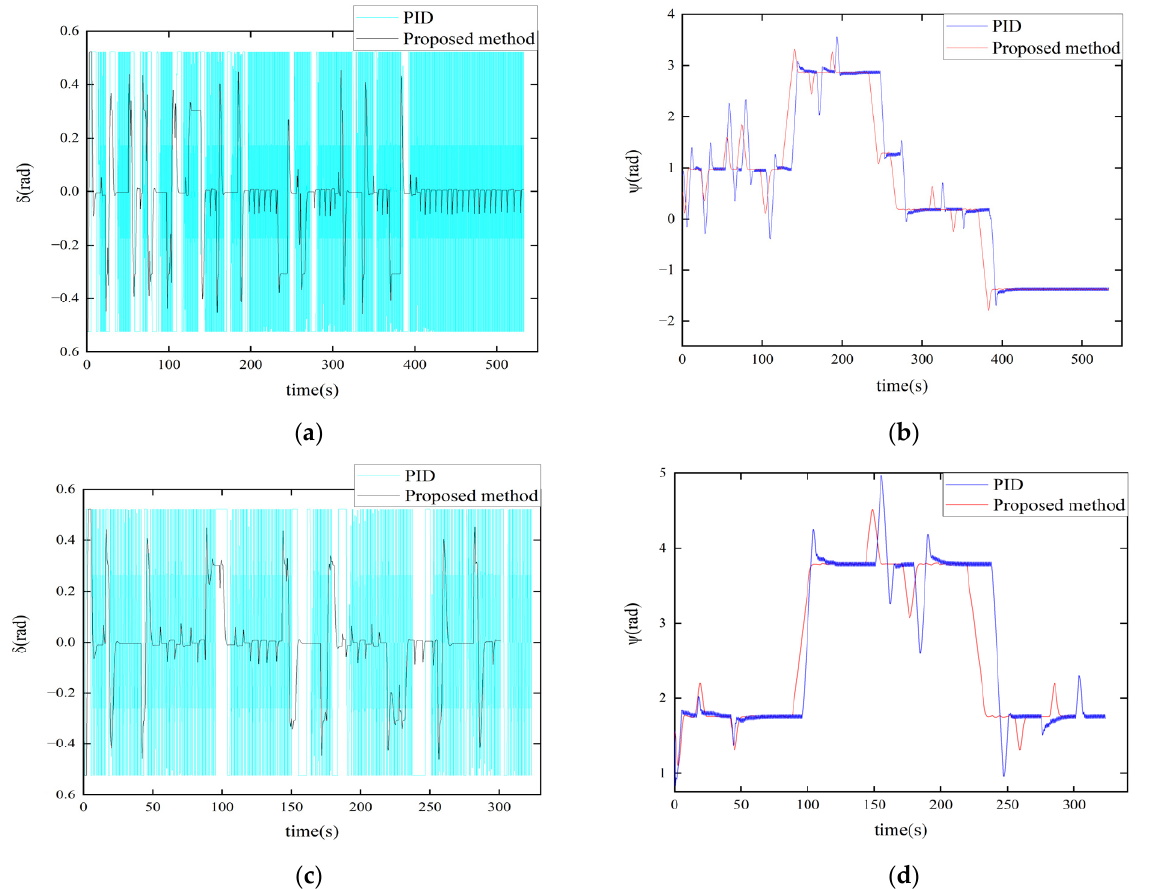
Figure 7. The input and output effects under the control of two algorithms: ( a ) the rudder angle of path 1; ( b ) the heading angles of path 1; ( c ) the rudder angle of path 2; ( d ) the heading angles of path 2.